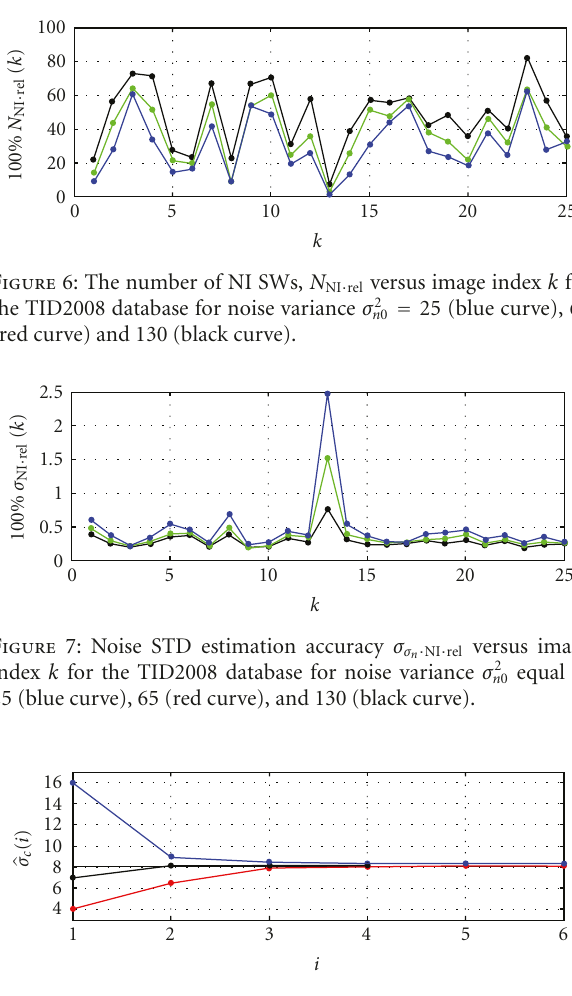
Figure 5: Distributions (empirical pdfs) of the noise STD estimates Figure 8: Convergence of NI+DCT noise STD estimator. Initial estimates (black curve); pdf for 7 × 7 NI SWs: (a) pdf of (cid:19) σ x · ( t 0 , s 0 ) guess for noise STD (cid:19) σ n · i = 0 ≈ 7 . 0 (black curve), (cid:19) σ n · i = 0 = 16 . 0 (blue of sample STD for the DCT based method (green curve); pdf of curve) and (cid:19) σ n · i = 0 = 4 . 0 (red standard sample STD (green curve). The true value σ n 0 is marked as dashed vertical line; (b) pdf of the normalized noise STD estimates for fBm and DCT-based estimators. True noise STD is marked by dashed vertical line.